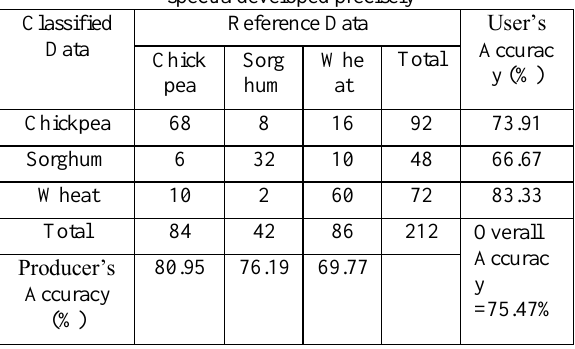
Figure 2: Image data: a) Hyperion data, b) Classified image using field spectra developed conventionally, c) Classified image using field spectra developed precisely based on spectral similarity, d) Zoomed portion of encircled area for image classified using spectra developed conventionally, e) Zoomed portion of encircled area for image classified using spectra developed precisely. Table 10: Error matrix for the image classified using field